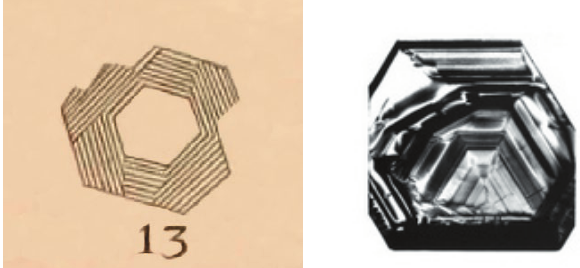
Fig. 13. Growth steps in a plane of quartz when seen down the c-axis. Left: enlargement of Steno’s sketch (Stenone [2]; see Fig. 12). Right: X-ray topographic image of quartz exhibiting the typical dis- locations and bands due to crystal growth (modified after Authier, 2013 [3]).